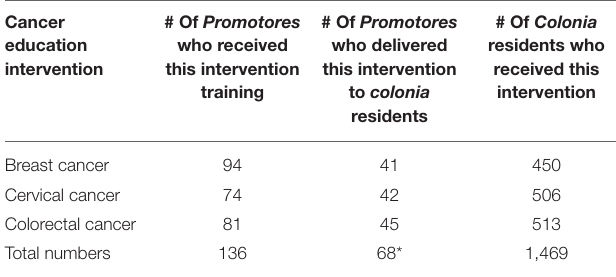
TABLE 1 | The number of residents receiving the specific ÉPICO cancer education interventions delivered by Promotores